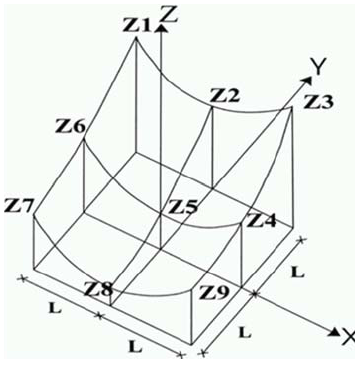
Figure 3. 3 x 3 elevation sub-matrix used to assess morphometric factors. 2 Fig. 3. 3 × 3 elevation sub-matrix used to assess morphometric fac-